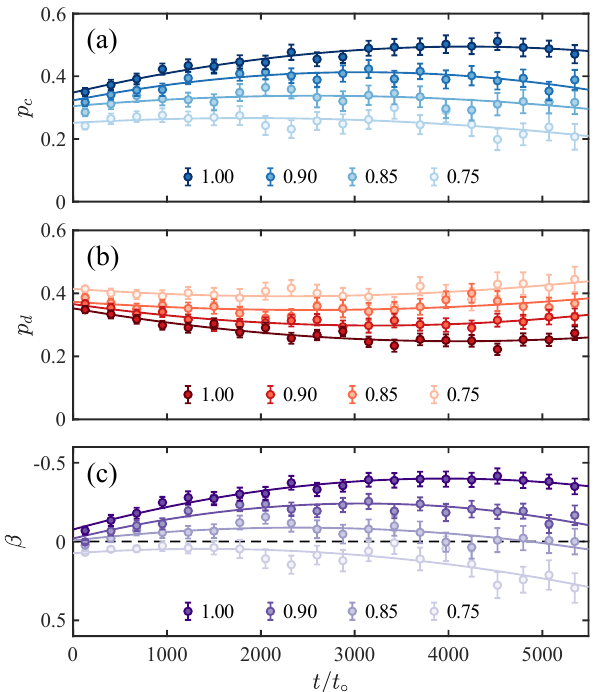
Figure 2: Fractional population curves of (a) vortex clusters and (b) vortex dipoles, as well as (c) the resulting inverse vortex temperature β , measured using the cluster population [ 24 ] . All data points have been ensemble averaged over 50 stochastic realisations, as well as temporally binned, and the error bars correspond to the standard error in the mean of each measurement. The legend in each subfigure indicates the condensate fraction, and the solid lines shown are quadratic fits to the data, serving as a guide to the